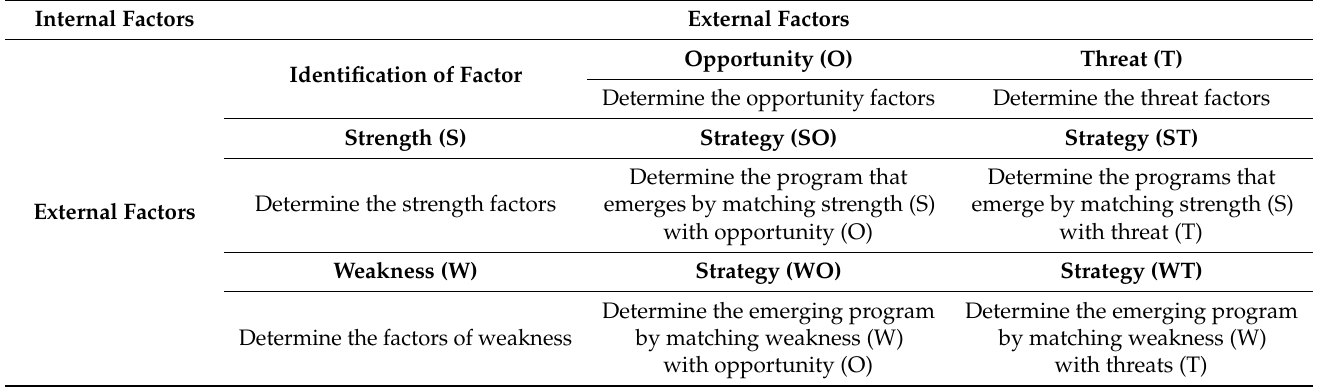
Table 2. SWOT analysis